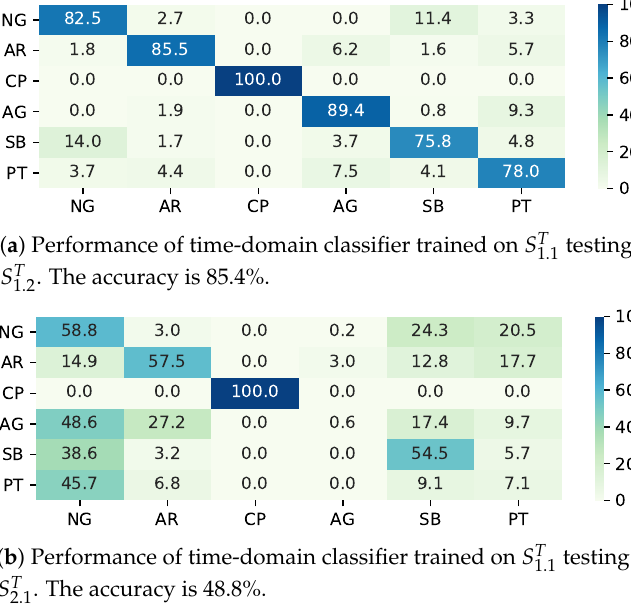
Figure 5. Normalized confusion matrices (in %) of SVM-based terrain classification on sample set S 2 . NG, AR, CP, AG, SB, PT denote natural grass, asphalt road, cobble path, artificial grass, sand beach, plastic track,